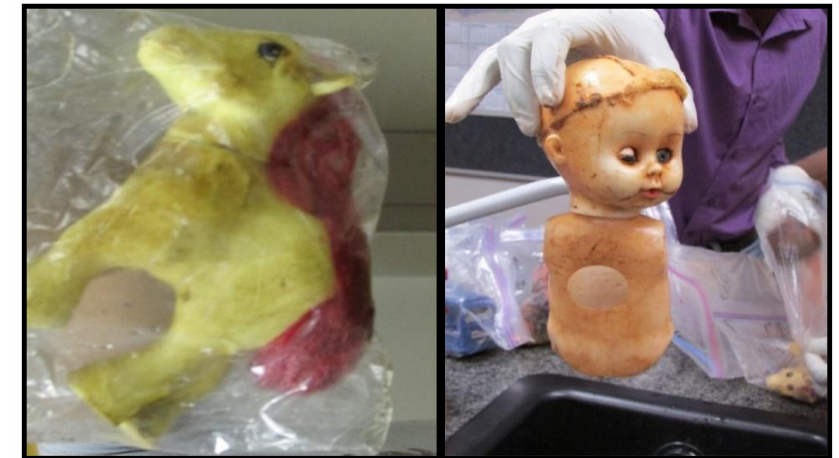
Figure 1. Existing toys.